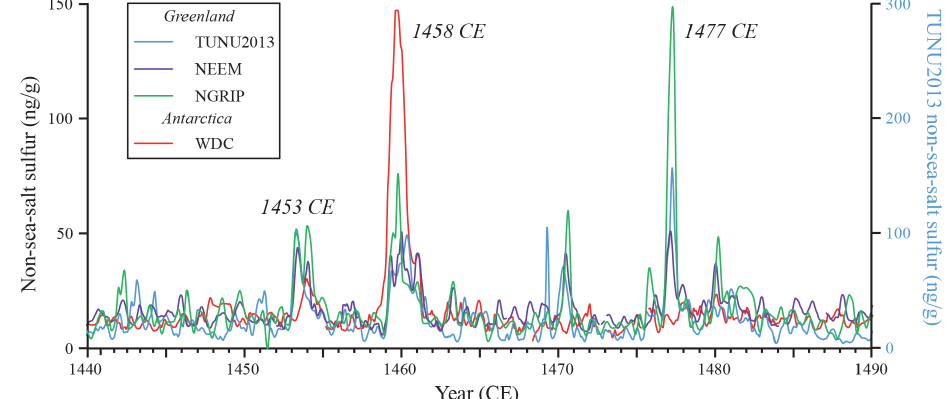
Figure 1. Bipolar comparison of sub-annual-resolution ice-core non-sea-salt sulfur concentrations between 1440 and 1490CE. Greenland data from the NEEM-2011-S1 ice core (Sigl et al., 2013), the TUNU2013 ice core (Sigl et al., 2015) and the North Greenland Ice Core Project (NGRIP) ice core (Plummer et al., 2012), all plotted using the annually counted NS-2011 chronology (Sigl et al., 2015). Antarctic data are from the annually counted West Antarctic Ice Sheet Divide (WDC) ice core on the WD2014 age scale (Sigl et al.,